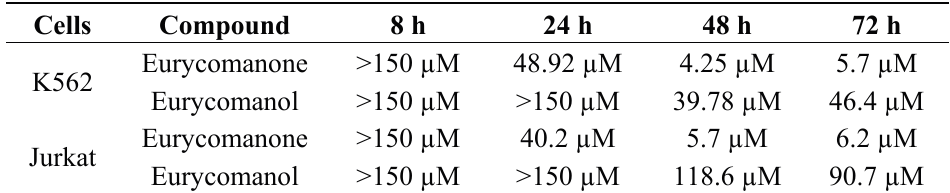
Table 1. The effect of eurycomanone and eurycomanol on K562 and Jurkat cell viability. IC 50 values were determined using Prism 6.0 (GraphPad), based on cell quantification performed with the trypan blue exclusion test.